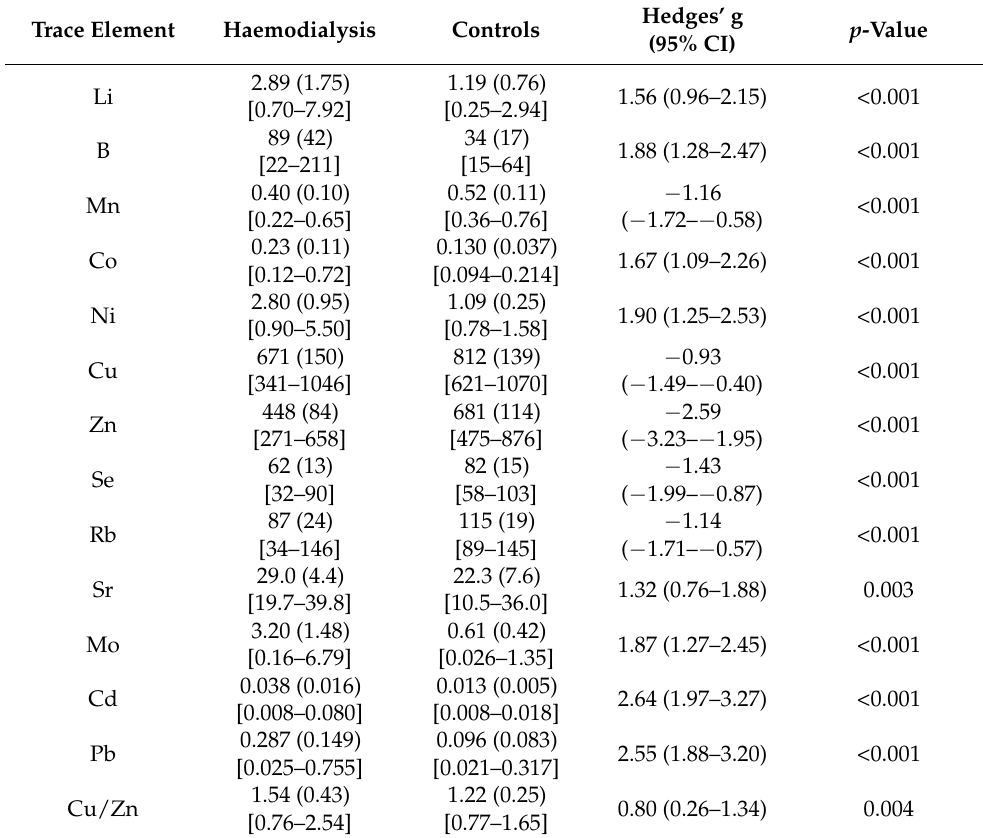
Table 2. Mean (SD) and [range] for the trace element concentrations ( µ g/L) and Cu/Zn ratio in serum of haemodialysis patients and controls. Hedges’ g was used to estimate the effect size of haemodialysis on trace element